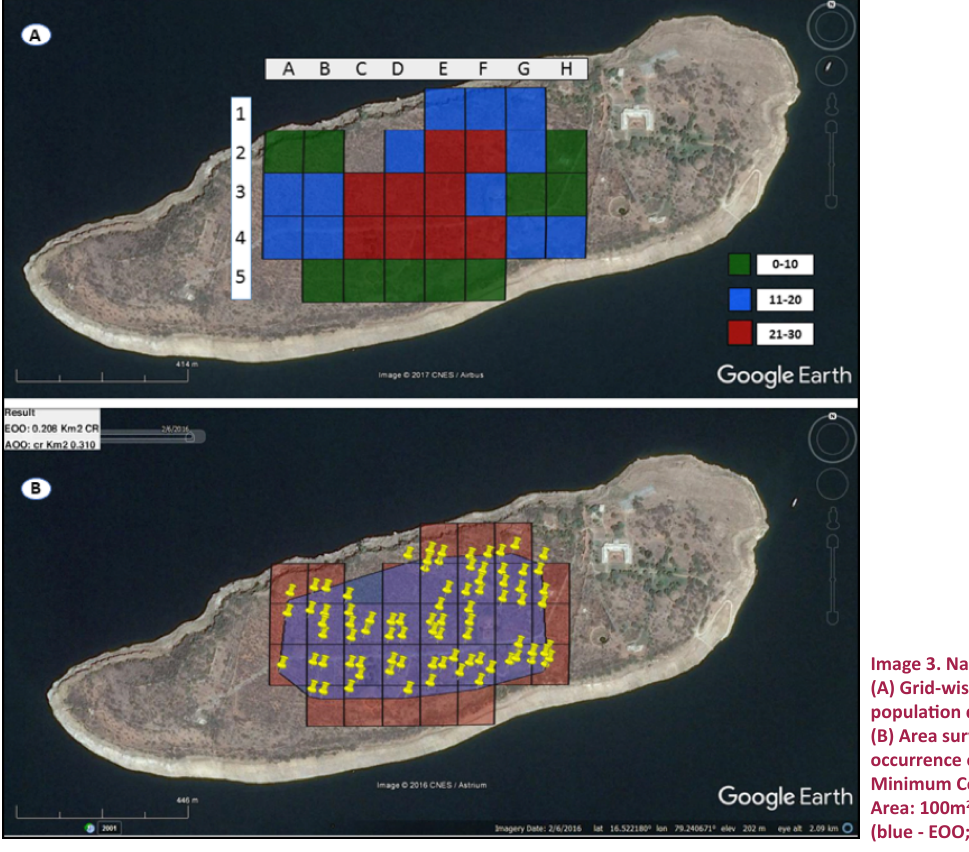
Image 3. Nagarjunakond Island. (A) Grid-wise categorization of population density in the Island; (B) Area surveyed for the occurrence of target species. Minimum Convex Polygon - Polygon Area: 100m 2 , perimeter 0.31km (blue - EOO; red -